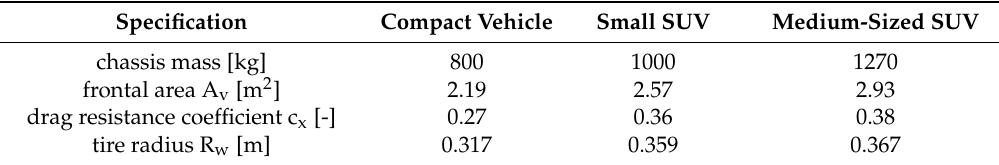
Table 4. Main vehicle specifications of the three vehicle segments.